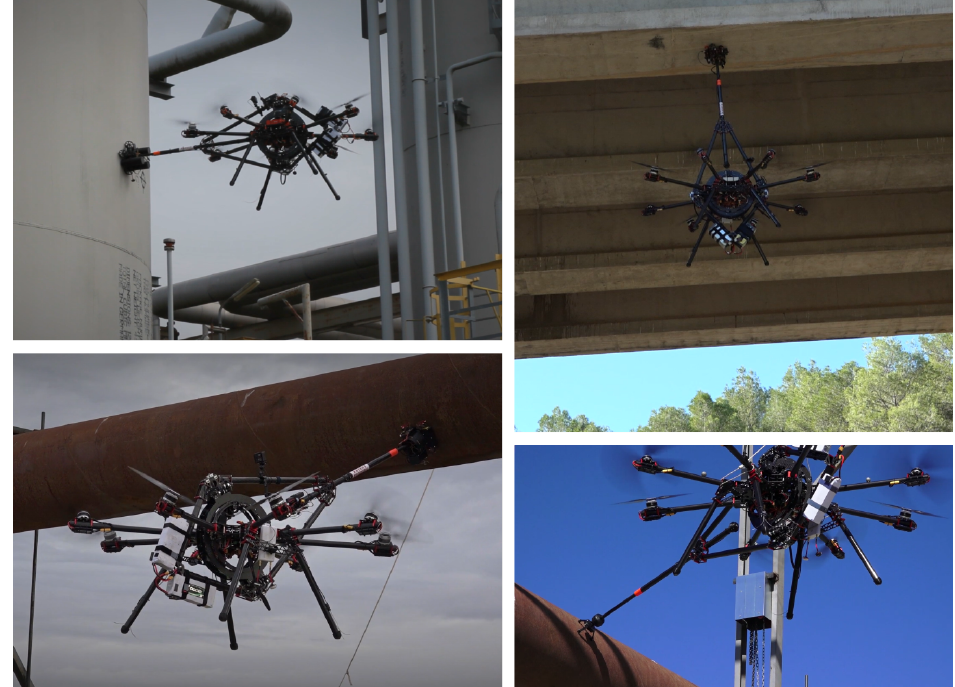
Figure 3. AeroX in contact inspection of surfaces with different positions orientations in different outdoor experiments and with different end-effectors: inspecting pipes ( bottom-left and bottom-right ), horizontal ceilings ( top-right ) and vertical surfaces ( top-left